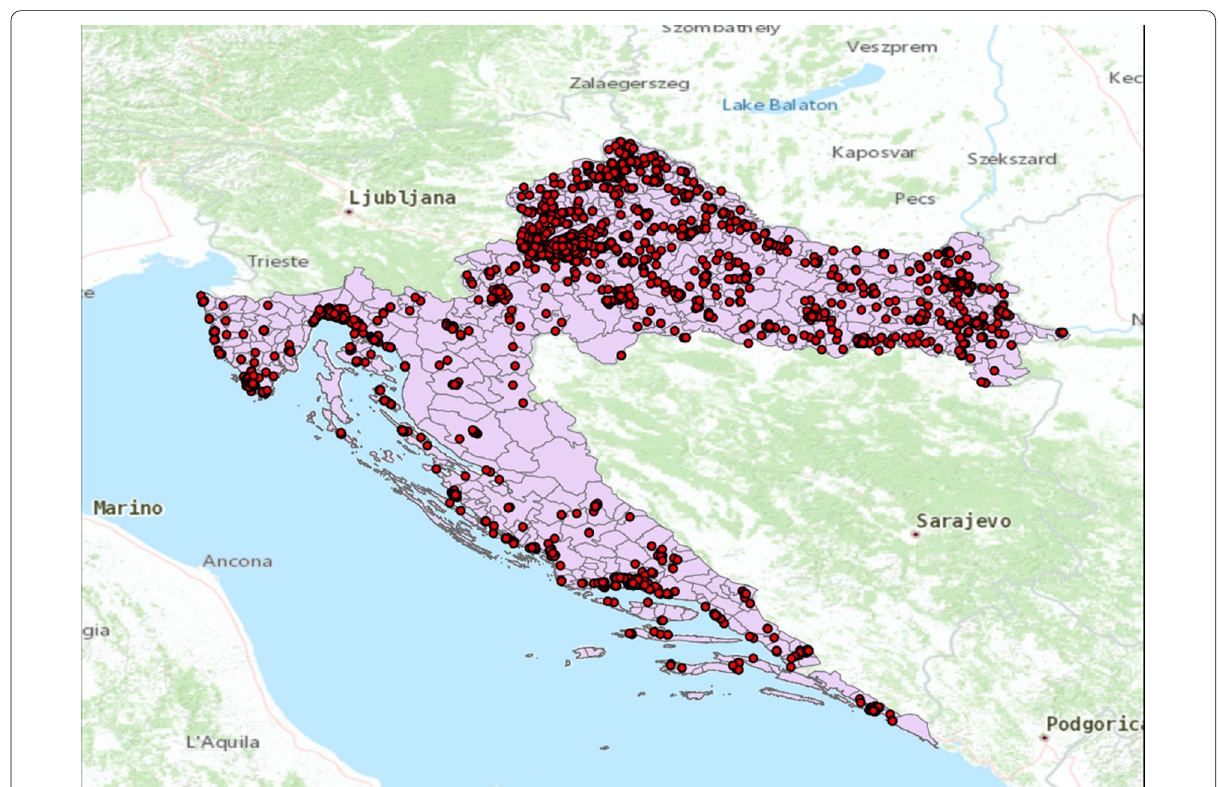
Fig. 1 Injury severity selected at intersections in